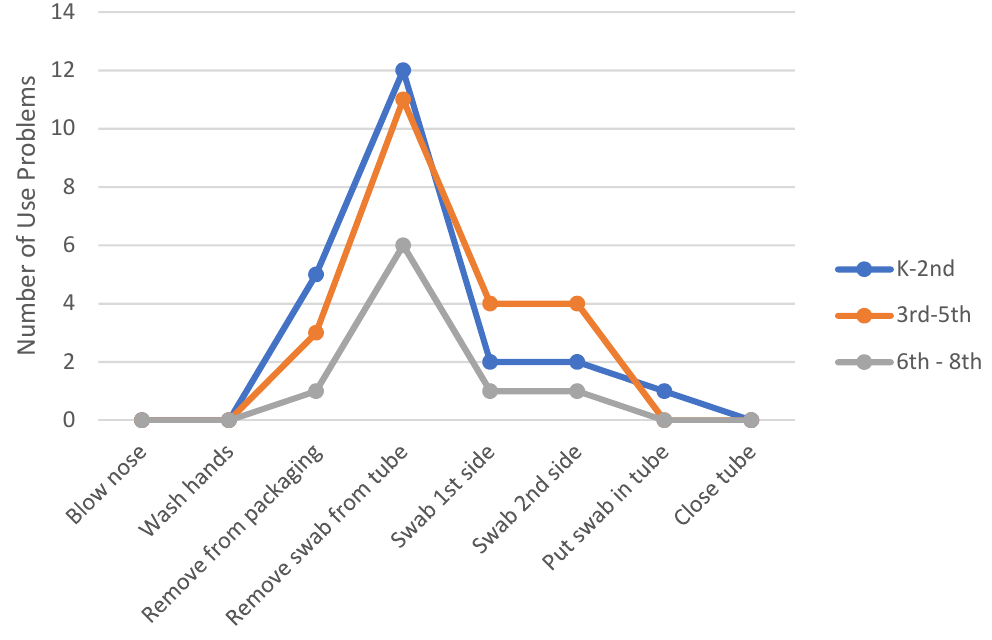
Figure 5. Number of use problems per task by grade range in Phase 3 using XpressCollect.